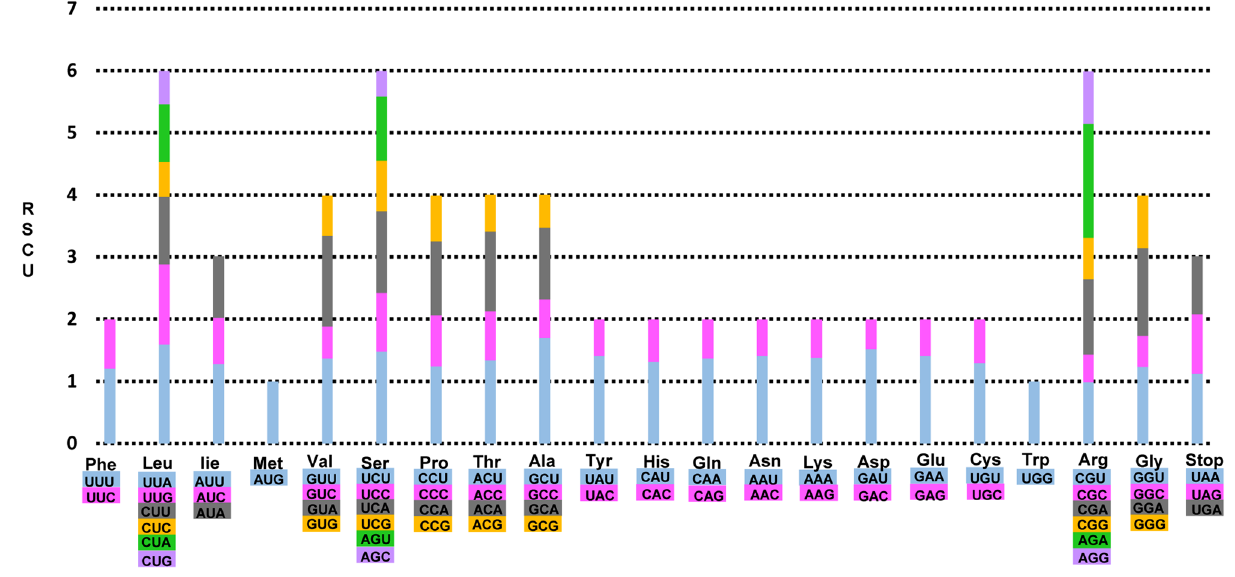
Figure 3. Codon distribution and relative synonymous codon usage (RSCU) in eight endemic Rubus in Taiwan. The RSCU values are represented on the y-axis, while the codon families for each amino acid are denoted on the x-axis.